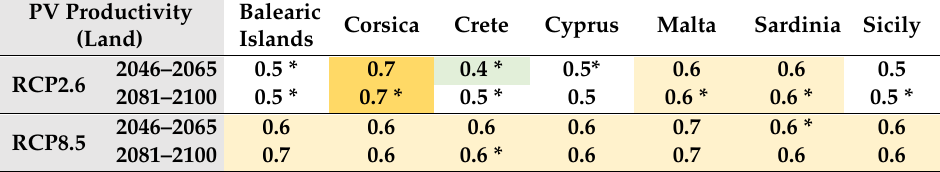
Table 6. Normalized changes (Nc) for PV productivity for each island, scenario and time period. Deep green cells: Nc = 0–0.2; Light green: Nc = 0.3–0.4; White: Nc = 0.5; Light yellow: Nc = 0.6–0.7; Deep yellow: Nc = 0.8–1. Nc and Nu are computed over land. The * indicates the cases in which Nu > 0.5.